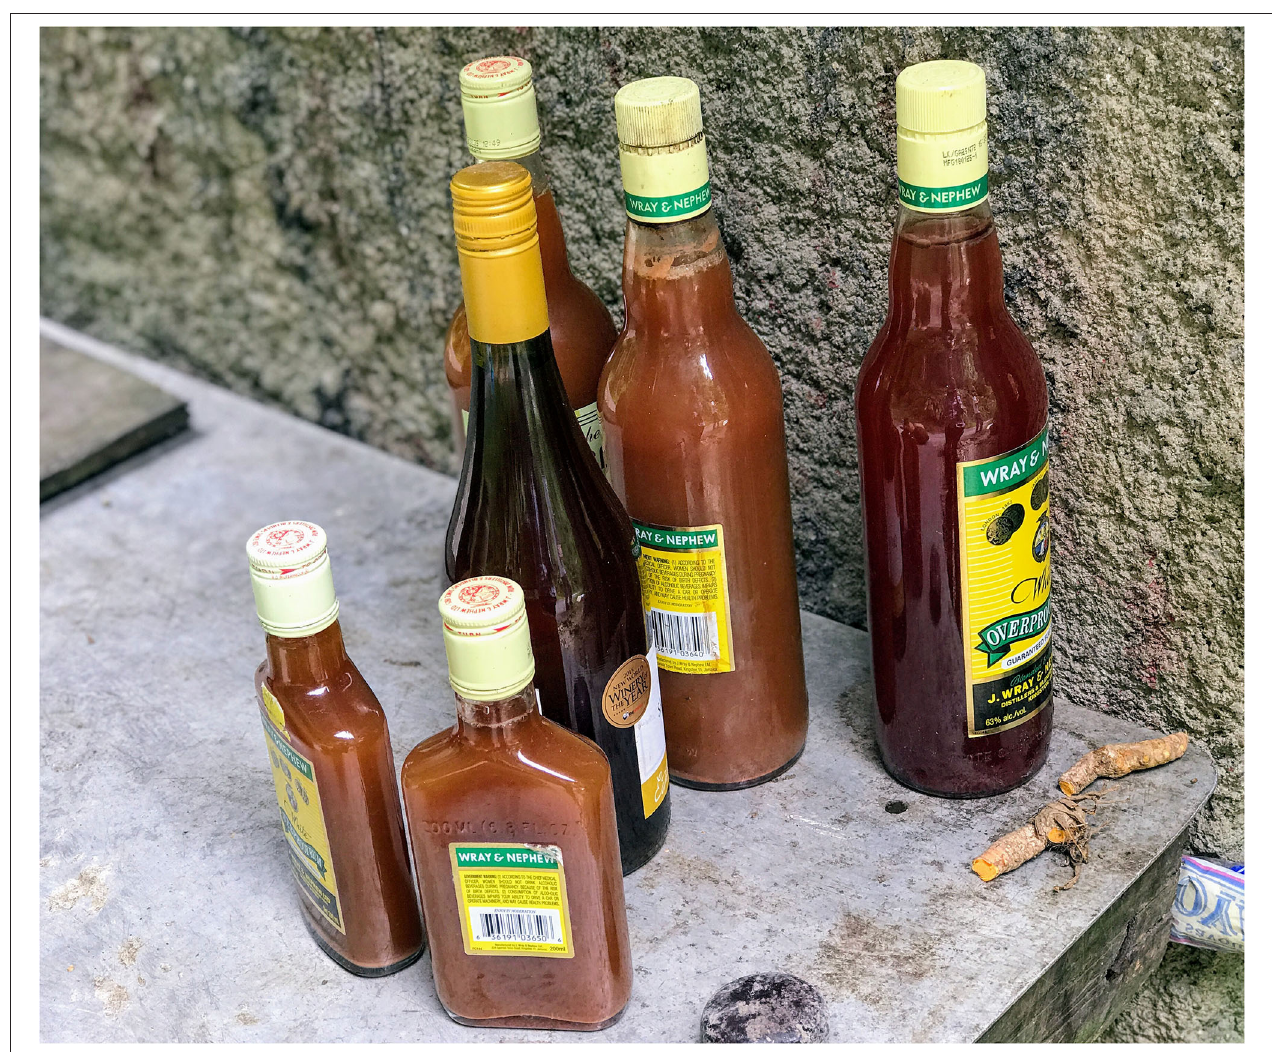
FIGURE 5 | The final artisanal product is stored in recycled bottles of rum (or occasionally other types of bottles, such as wine or Campari), often with their original labels (photo credit